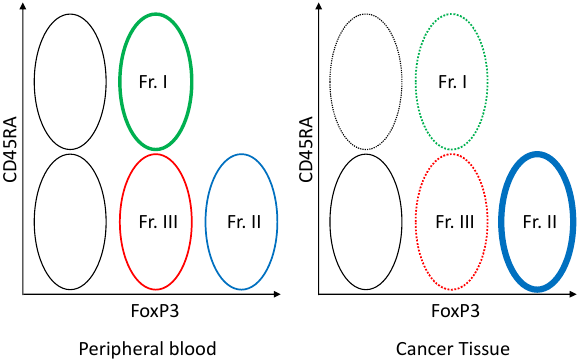
Figure 7. Foxp3 + T cell subset in the blood and tumor tissue. FoxP3 low CD45RA + naïve Treg (Fr. I) can be viewed as cells that have just been supplied from the thymus. If these naïve Treg are activated by the TCR signal, CD45RA becomes negative and FoxP3 is upregulated, yielding FoxP3 high CD45RA- e ff ector Treg (Fr.II). E ff ector Treg (Fr. II) expresses high levels of CCR4. Regarding FoxP3 + cells, the